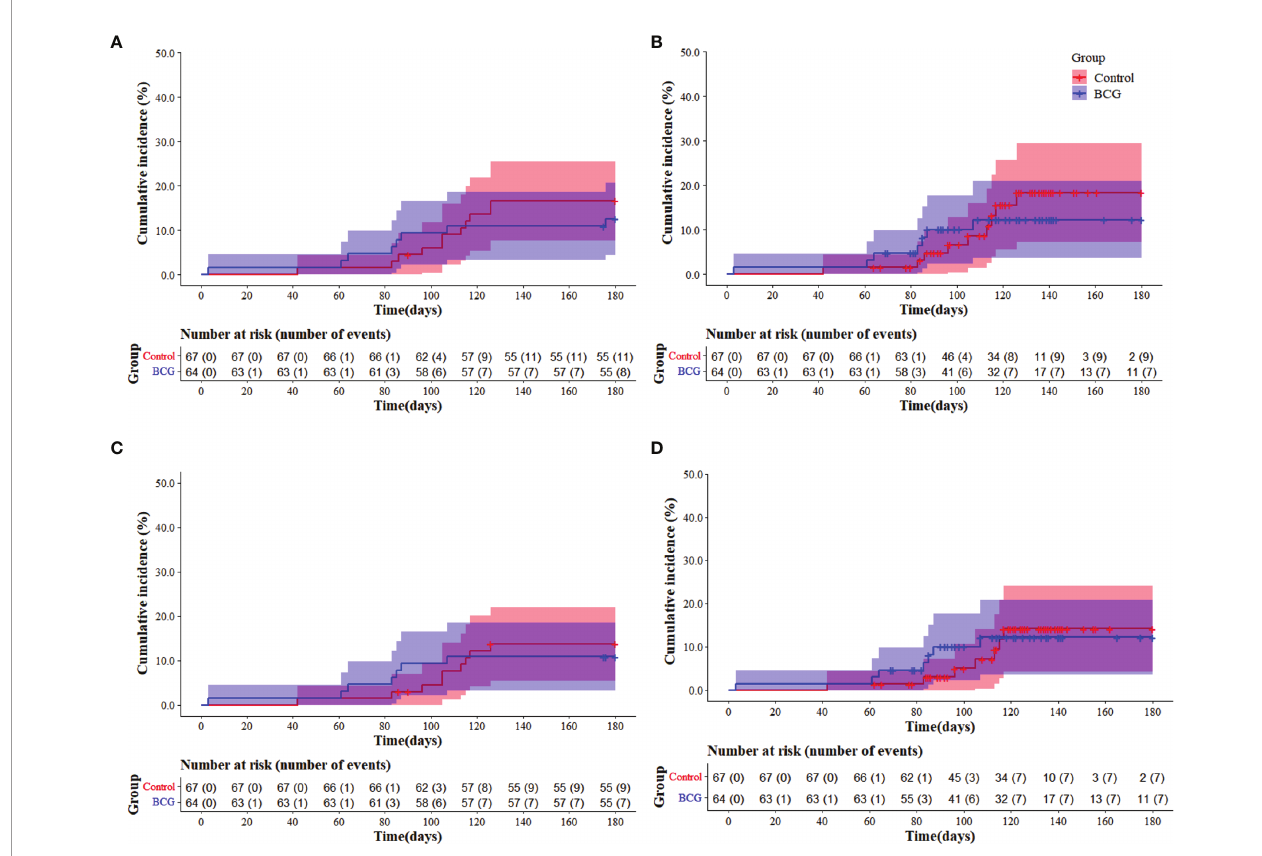
FIGURE 2 | Cumulative incidence Kaplan-Meier curves of COVID-19 cases (laboratory-con fi rmed COVID-19) in two scenarios: without censoring for COVID-19 vaccination (A) and with censoring for COVID-19 vaccination (B) . The cumulative incidence Kaplan-Meier curves of symptomatic COVID-19 cases are also shown in two scenarios: without censoring for COVID-19 vaccination (C) and with censoring for COVID-19 vaccination (D) . Blue lines and shadings represent the revaccinated with BCG group (BCG) cumulative incidence of cases and 95% CI, respectively. Red lines and shadings represent the unvaccinated group (Control, unvaccinated) cumulative incidence of cases and 95% CI, respectively.